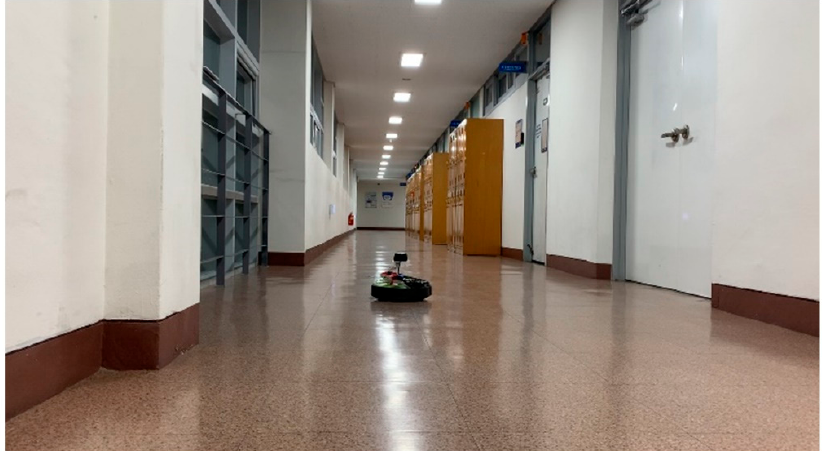
Figure 20. Position (marked 7 in Figure 15) in indoor space where first autonomous scanning experiment was performed.